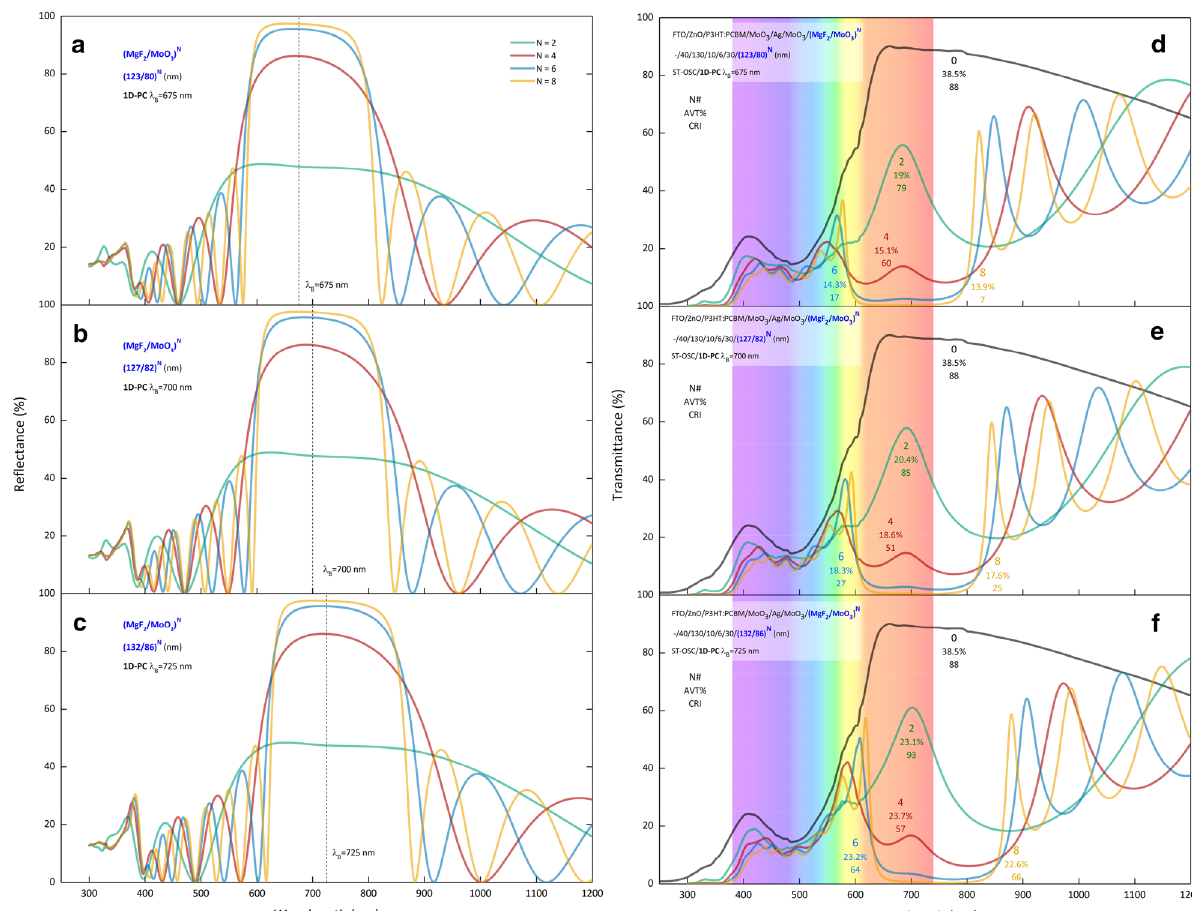
Figure 1. Calculated optical spectra of 1D-Photonic crystal and semi-transparent organic solar cells. Reflection spectra of PBGs designed for N = 2, 4, 6, 8 periods with the MgF 2 /MoO 3 ) N 1D-PC system at ( a ) λ B = 675 nm, ( b ) 700 nm, ( c ) 725 nm. Transmission spectra of the ST-OSC/(MgF 2 /MoO 3 ) N for N = 2, 4, 6, 8 periods d λ B = 675 nm, ( e ) 700 nm, ( f ) 725 nm. The dashed lines in ( a – c ) represents the Bragg wavelength set in the calculations. The electromagnetic spectrum is given in the visible region range at d, e, and f.